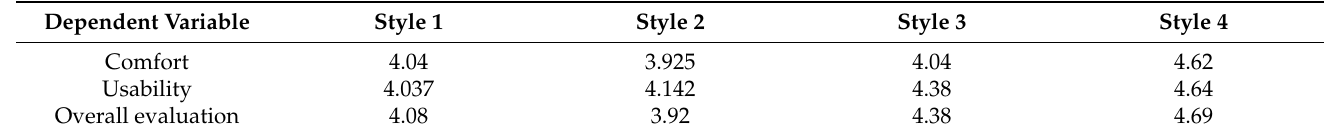
Table 20. Subjective evaluation scores of different styles of keys.